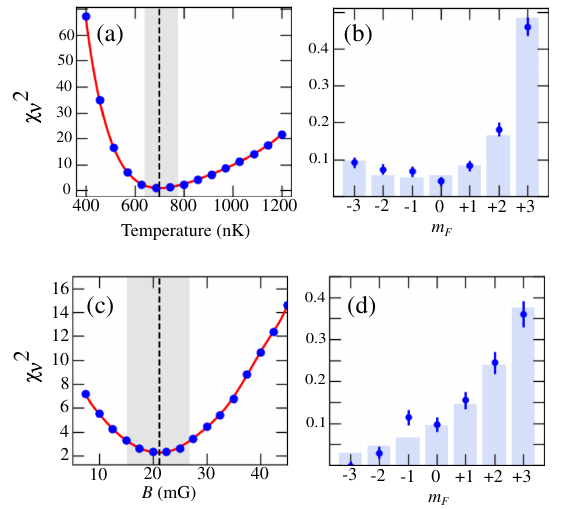
FIG. 13. Experimental extraction of the quantum Fisher in- FIG. 12. Extraction of the spin temperature T and the spin formation. The temperature is fixed at T ¼ 280 nK. In (a) – (c), we spin with a χ 2 analysis. (a) shows a χ 2 ν ð T Þ curve magnetic field B represent the spin populations of the Cs atoms for different spin magnetic fields B : The dots are the experimental points, and the (the magnetic field is fixed at B ¼ 10 mG) and (c) represents a ð B Þ curve (the temperature is fixed at T ¼ 1 μ K ). In each curve, χ 2 histograms are the theoretical expectation values. In (d), we ν represent the Bures distance between the different states centered the vertical dashed line represents the minimum value of the χ 2 ν , at B 0 ¼ 25 mG. In red, the Bures distance is inferred by the which marks the extracted T or B . The slightly gray band spin spin theoretical spin populations and in blue by the experimental represents the standard deviation corresponding to an increase of χ 2 ¼ 702 þ 60 ¼ 21 . 6 þ 5 . 7 ν of 1. We find T spin − 76 for (a) and B spin − 6 . 1 for (c). (b) and (d) represent the measured populations (dots) and the best parameter of interest with the model (histogram).